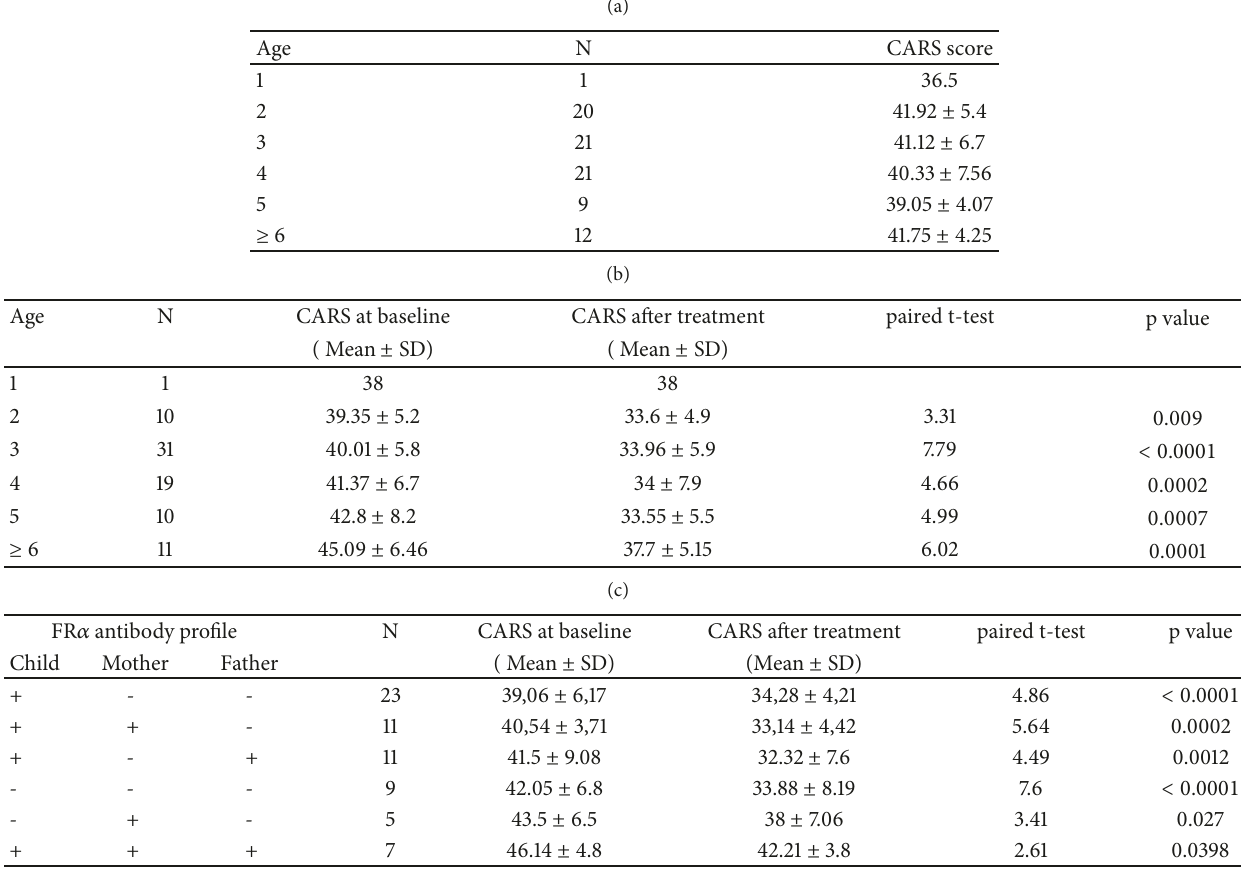
Table 2: The upper part shows the CARS score in function of age in the reference group of 84 untreated children with infantile autism. The table below shows the effect of treatment after 2 years upon the CARS score evolution in 82 children with a significant decrease for each age group. The lowest part of the table shows the CARS at baseline and after two-year treatment for 66 families in function of the profile of positive (+) or negative (-) FR 𝛼 autoantibodies in the child, mother, or father. N stands for the number of